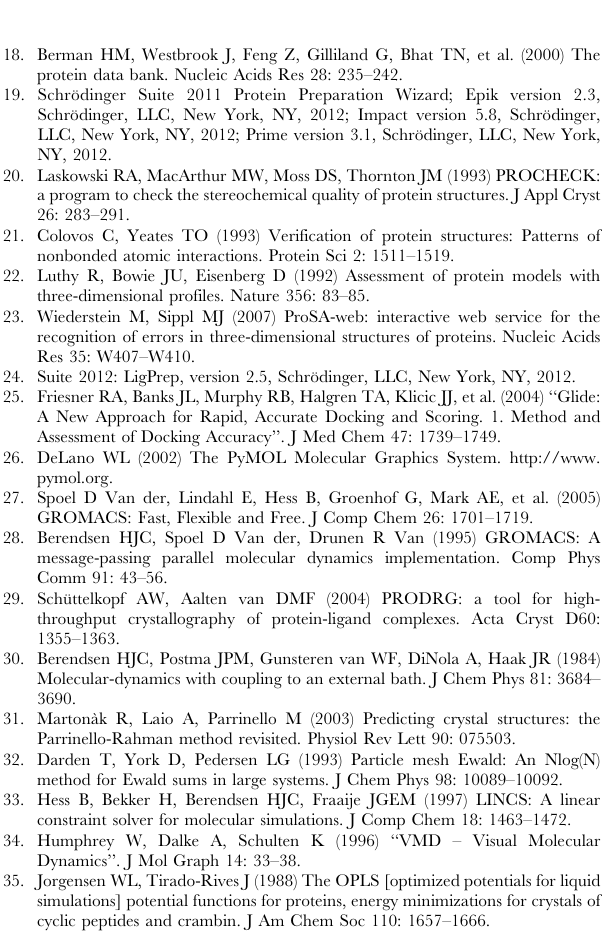
Figure S1 Multiple sequence alignment of 30 F3GT protein sequences. (PDF) Figure S2 Multiple sequence alignment between query (30F3GTs) and template (PDB ID: 2C1Z, 3HBF and 3WC4). (PDF) Figure S3 Image showing docked complexes of three positive and two negative control ligands in the acceptor binding pocket of Dianthus caryophyllus ( Dianthus_1 ). (TIF) Figure S4 Image showing docked complexes of three positive and three negative control ligands in the acceptor binding pocket of Diospyros kaki . (TIF) Figure S5 Image showing docked complexes of three positive and three negative control ligands in the acceptor binding pocket of Petunia hybrida ( Petunia_2 ). (TIF)